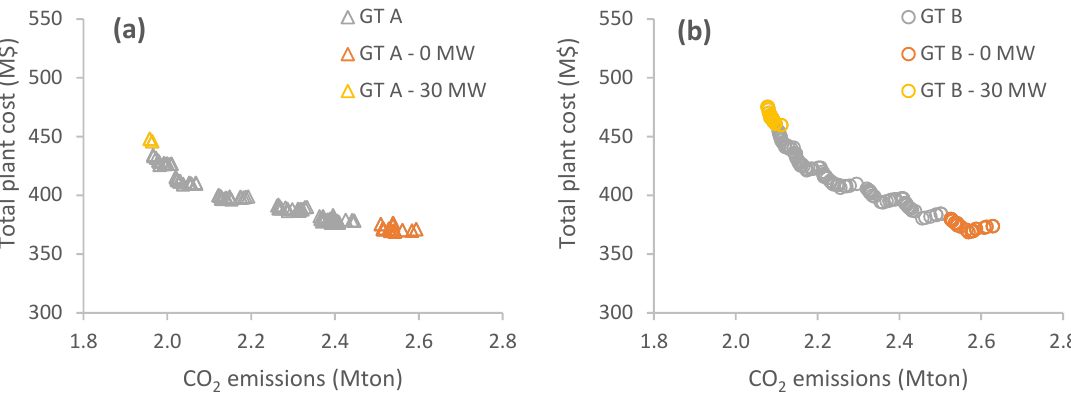
Figure 7. Decision map of the Pareto front showing trade-offs between total cost and CO 2 emissions for the designs based on GT A ( a ) and GT B ( b ). The results referring to no wind integration (0 MW) and maximum wind integration (30 MW) are highlighted.